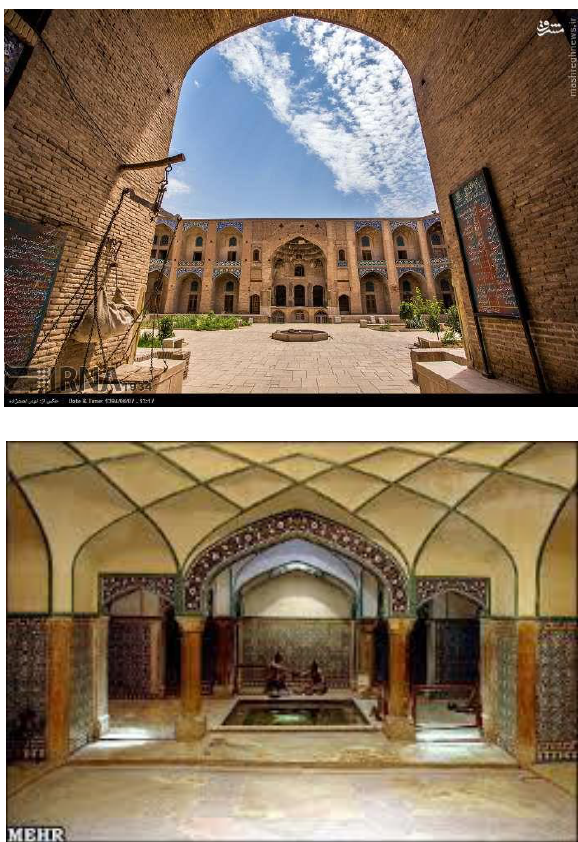
Figure 6-7. Public functions like the historic school and bath along the Bazar Direct observation in Grand Bazaar indicates the strengths and weakness of the case study. Conducting direct observation in the field make it possible to extract the strength and weakness of Grand Bazaar as a historical public place; table 1 indicates the strength and weakness in terms of functional dimension, social, perceptual, and physical